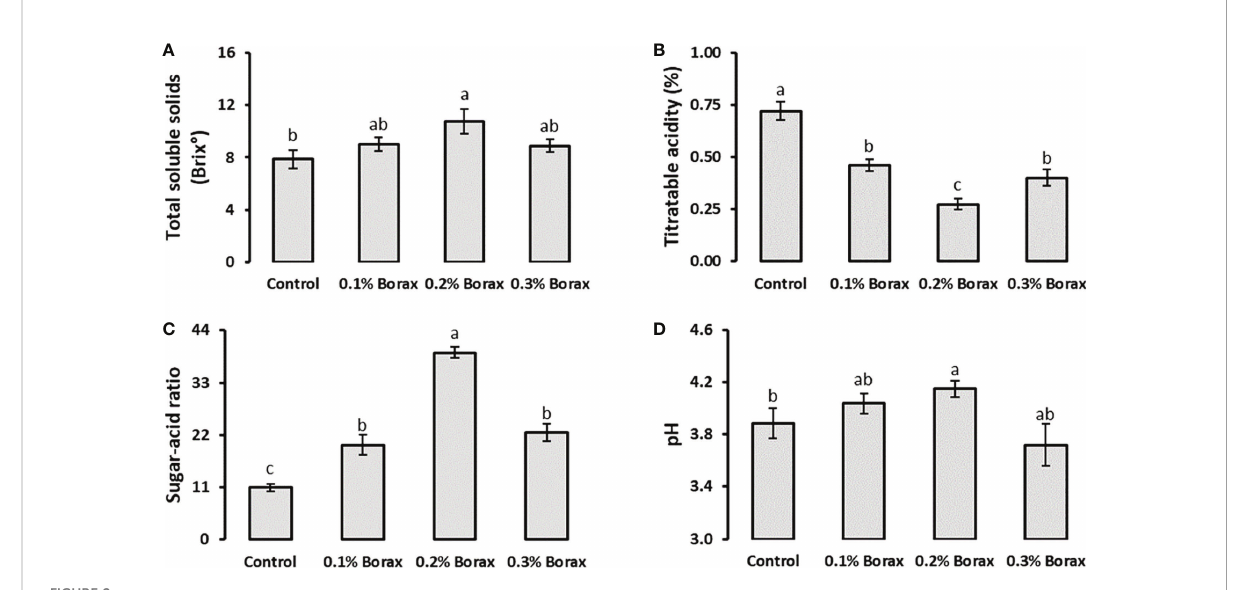
FIGURE 2 Effect of foliar application of B on total soluble solids (A) , titratable acidity (B) , sugar-acid ratio (C) , and pH (D) of loquat fruits. Same letters indicate non-signi fi cant difference among treatments according to Fisher ’ s least signi fi cant difference (LSD) test, when p ≤ 0.05 . Vertical bars indicate mean ± standard error (n=4, 4-block RCBD